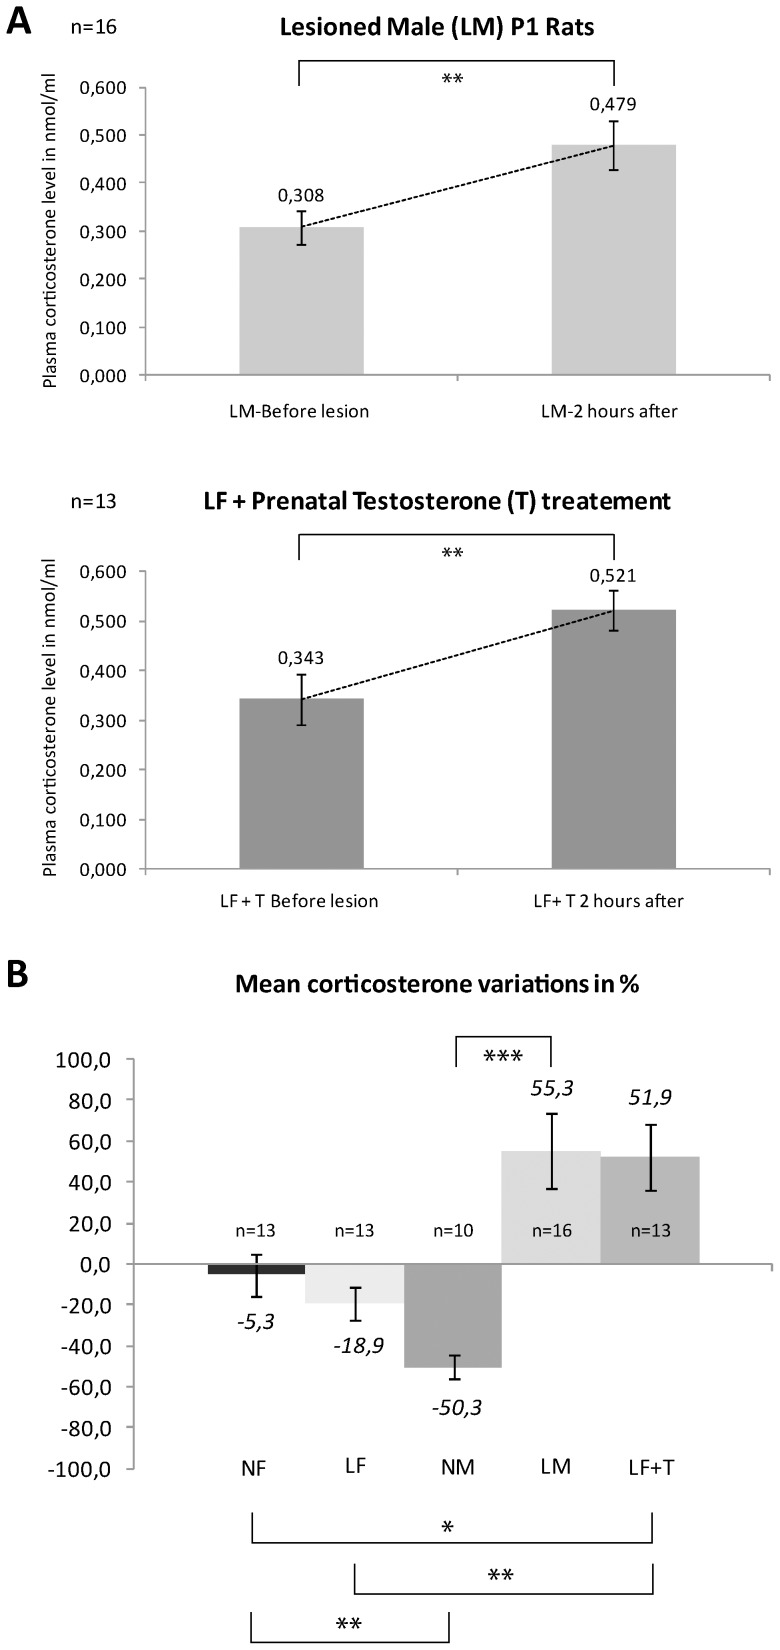
Plasma corticosterone level (PCL) changes following treatments.
A) Histrograms showing changes in PCL before and after the cortical lesion in nmol/ml at P1 in males (top) and in females, bottom). B) Mean PCL variations for all the experimental groups in percentages. Note that the LM and LF+T groups were the only ones that showed an increase of corticosterone levels following cortical dysplasia induction at this age, whereas the others showed diminution. These increases were statistically different from their controls, notably LM compared to NM (*** p<0.001), LF+T compared to NF (* p<0.05) and to LF (** p<0.01).